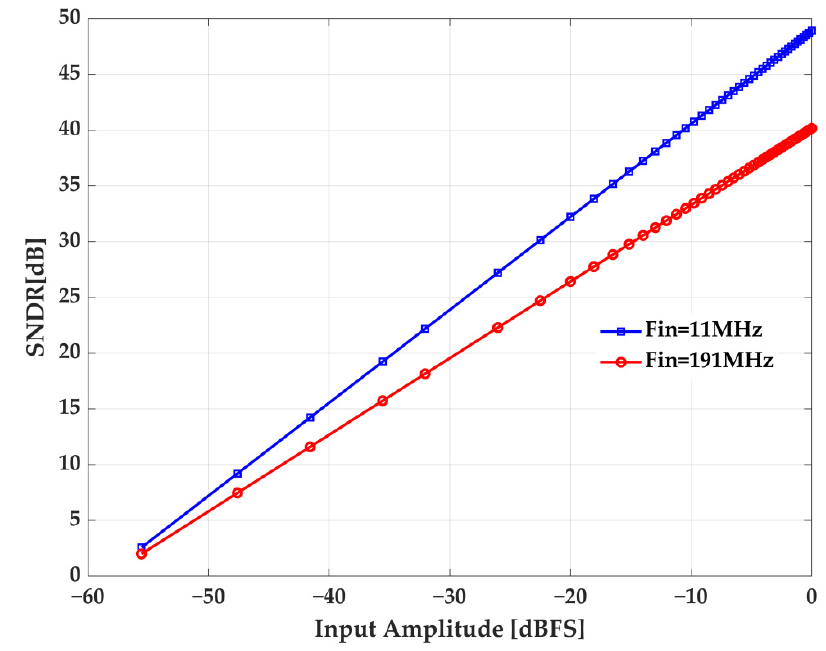
Figure 18. Measured SNDR versus input amplitude.